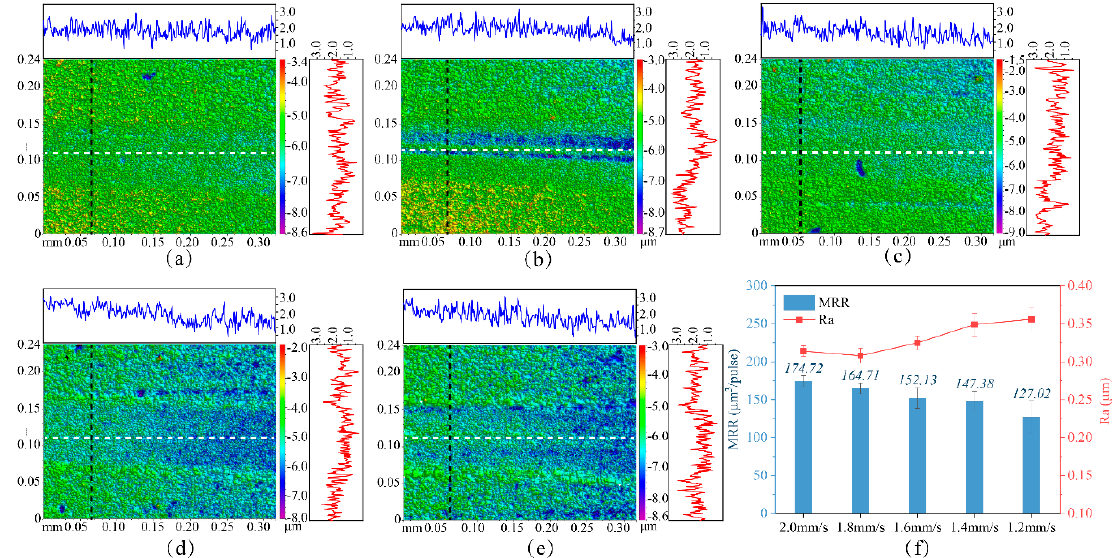
Figure 3. White light (WL) interferometer reconstructed results of fs laser-irradiated regions under different scanning speeds. ( a ) 2.0 mm/s, ( b ) 1.8 mm/s, ( c ) 1.6 mm/s, ( d ) 1.4 mm/s, ( e ) 1.2 mm/s, and ( f ) the surface roughness Ra and removal rate per laser pulse of diamond coating vs. scanning speed.